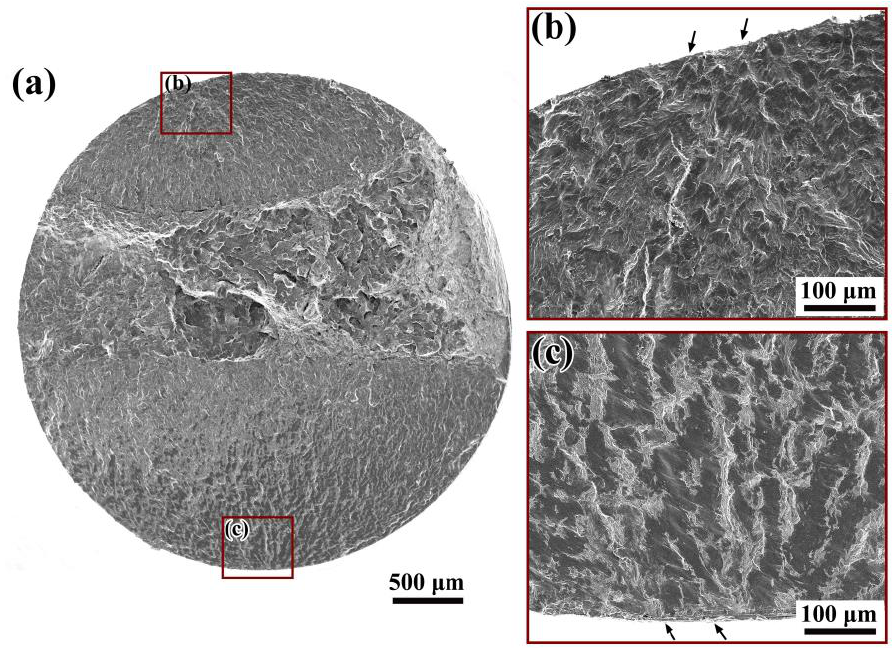
Figure 7. Surface slip-induced crack initiation under rotating bending loading, σ a = 415 MPa, N f = 1.72 × 10 5 cycles: ( a ) whole fracture surface, ( b , c ) details for crack initiation sites.